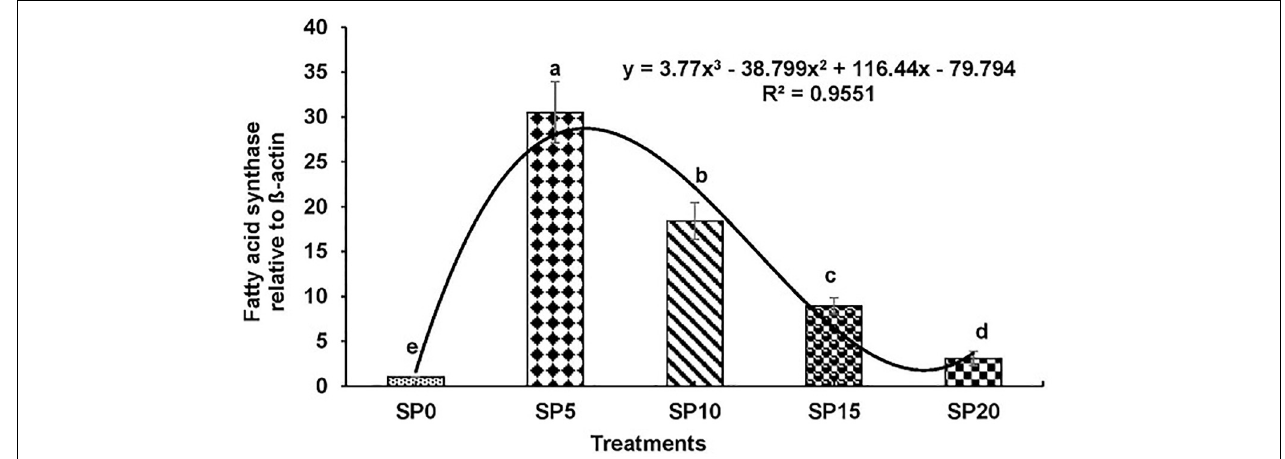
FIGURE 4 | Expression of fatty acid synthase ( fas ) relative to β -actin in hepatopancreas of five different diet-fed Cyprinus carpio . Bars with different superscripts are significantly different ( n = 3). A polynomial (order 3) relationship was found between the diet and expression of fads2d6 ( R 2 =